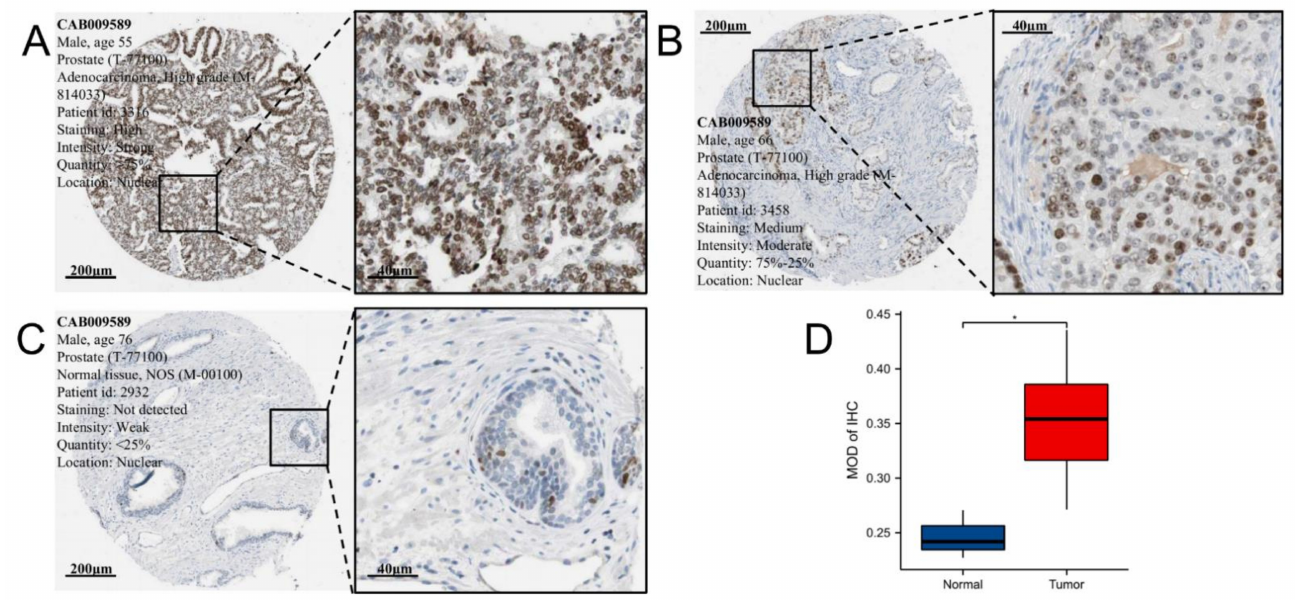
Figure 2. IHC analysis of EZH2. The representative photomicrographs of EZH2 IHC staining with ( A ) strong, ( B ) moderate, and ( C ) weak intensity. ( D ) MOD values of IHC between tumor and normal samples. p -values < 0.05 was presented as